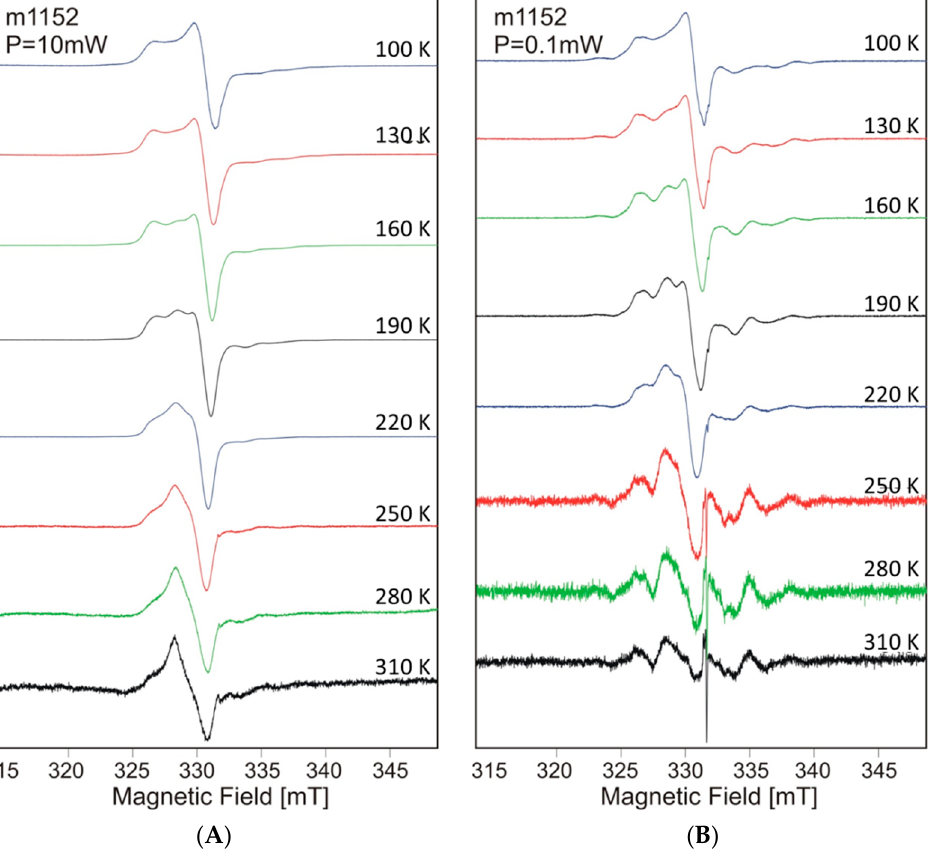
Figure 2. The spectra for aged tapes (51 kGy, low dose rate) made of unprotected XLPE after probe- irradiation with 10 kGy dose of gamma radiation and subsequent cryogenic EPR measurement with annealing. The spectra were recorded in the microwave powers of 10 ( A ) and 0.1 mW ( B ), respectively, in the temperatures 100–310 K.